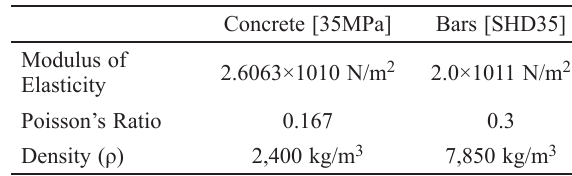
(a) Exposed curved parts in X-braced bars Fig. 22. Modification to the curved parts of X-braced bars